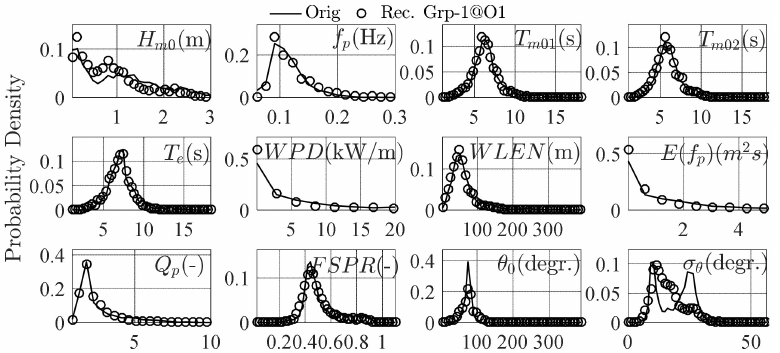
Figure 8. Probability distribution of partition KPs in Grp-1 at check point O1. Probability densities derived from spectra simulated with the original and the reconstructed boundaries are indicated by solid lines and circles, respectively. Each panel is titled according to the corresponding KP, and the x axis in each panel denotes the value range of the KP.